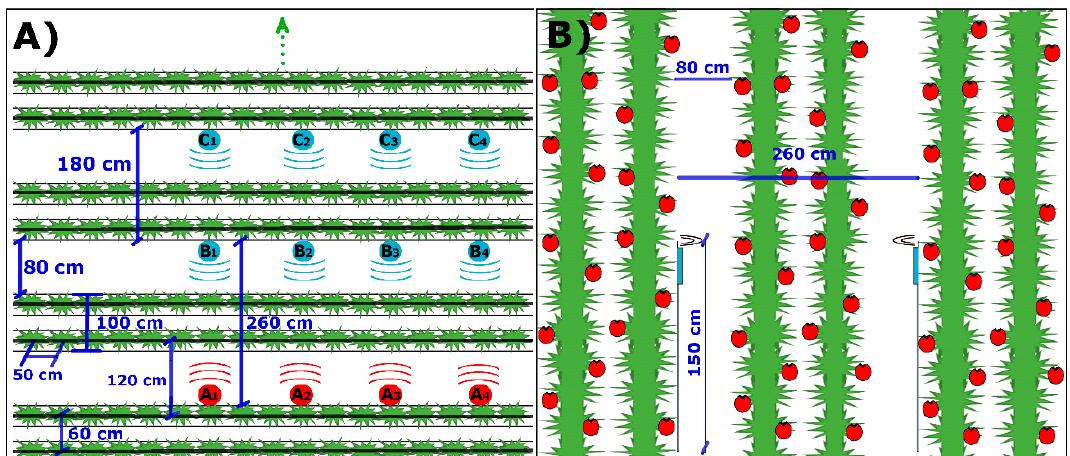
Figure 4. Tomato greenhouse diagram and WSN deployment layout in the tests. ( A ) View from above, ( B ) transverse view.